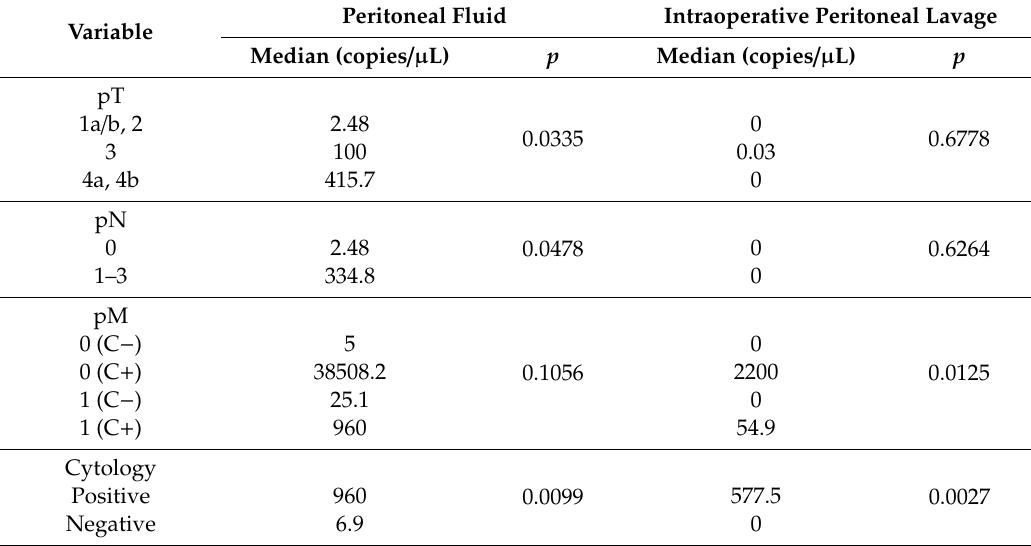
Comparison of Cytokeratin-19 (CK19) concentration values depending on selected clinical